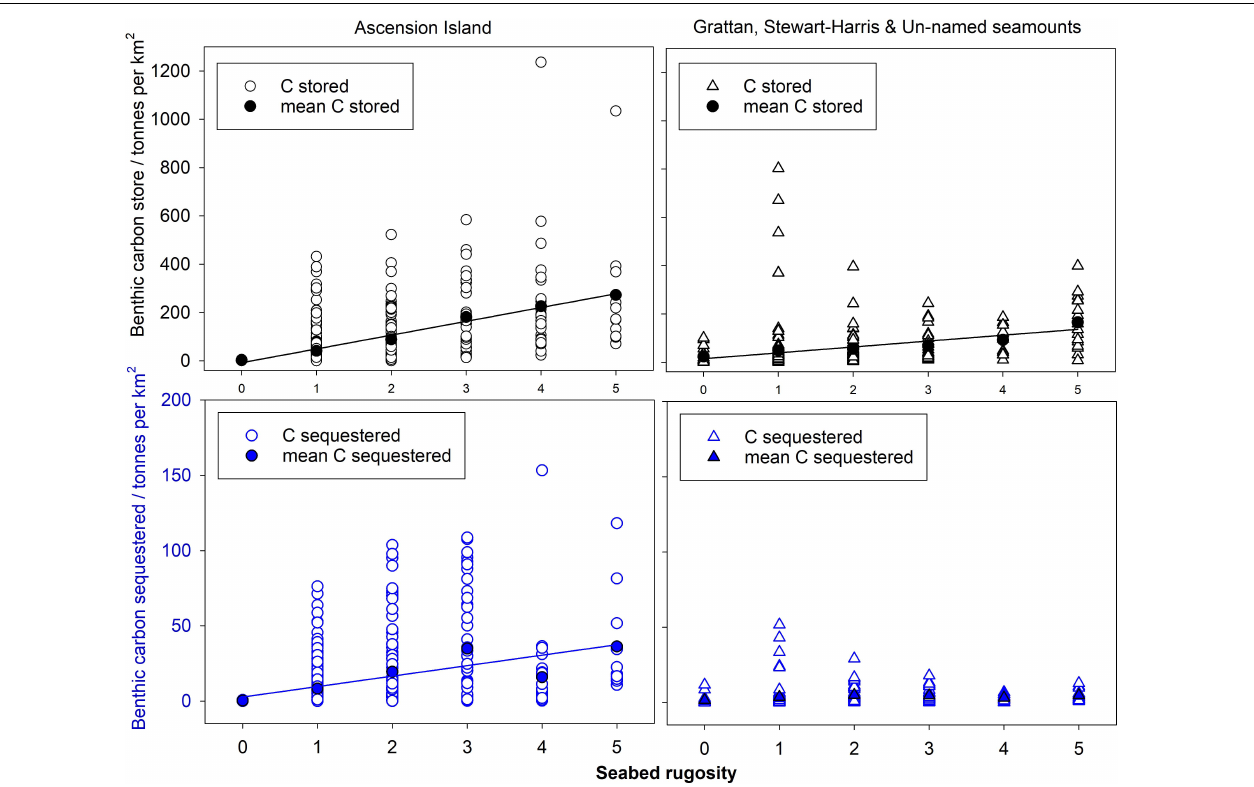
FIGURE 4 | Zoobenthic carbon storage and sequestration with rugosity levels in Ascension Island EEZ waters.